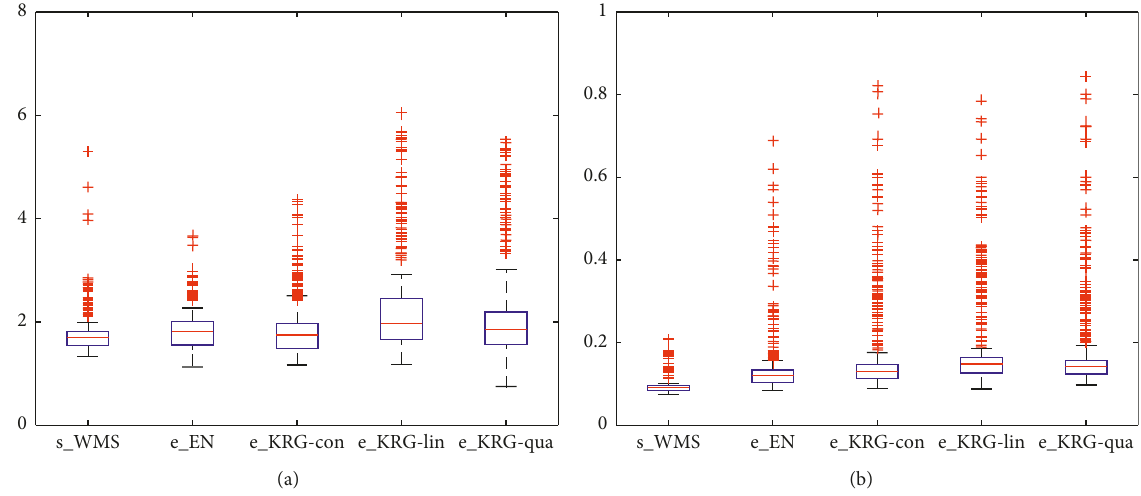
Figure 2: Maximum/minimum square root of the weighted mean square error and actual errors in prediction of different surrogates at corresponding locations. (a) Maximum square root of the weighted mean square error and corresponding actual errors. (b) Minimum square root of the weighted mean square error and corresponding actual